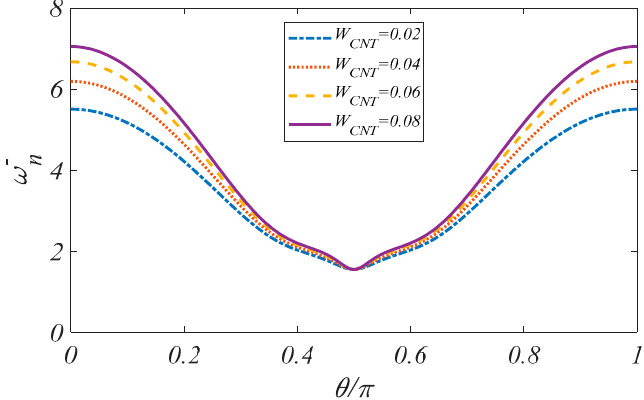
Figure 10. The effect of various weight fraction of CNTs on the nondimensional natural frequency of MHCAP with clamp-clamp boundary conditions for different orientation angles of carbon fibers and b/a = 4, h/b = 0.1, STR, T i = 273 [K], T o = 300 [K], V F = 0.2, FG-A, β = 1, K p = 10 [MN/m], and K w = 100 [MN/m 3 ].